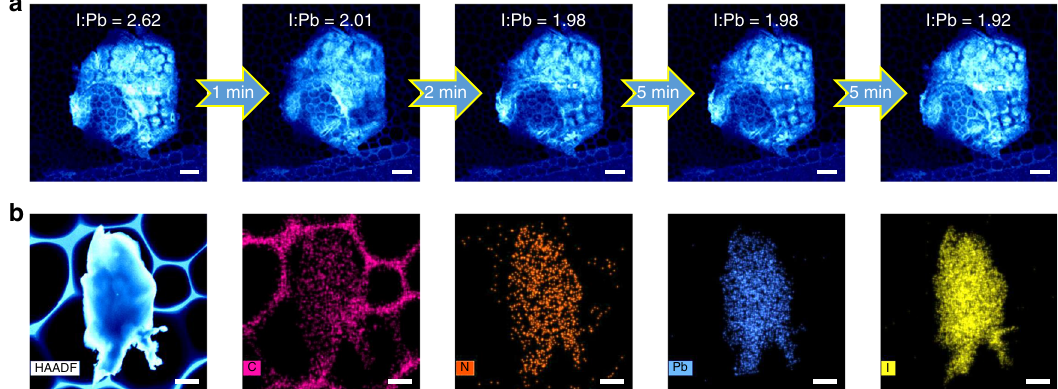
Fig. 4 The quantitative elemental analysis during the degradation of MAPbI 3 . a Scanning electron microscopy (SEM) images with the atomic ratio for I/Pb acquired from the corresponding energy-dispersive X-ray spectroscopy (EDX) mappings in Supplementary Fig. 10, showing that the atomic ratio of I/Pb gradually decreases to 2. The beam was blank for a certain time indicated by the arrows after every spectrum was acquired. b A STEM image and the corresponding EDX mappings for the quantitative elemental analysis (Supplementary Table 2). Scale bar, 5 μ m ( a ); 500 nm ( b )